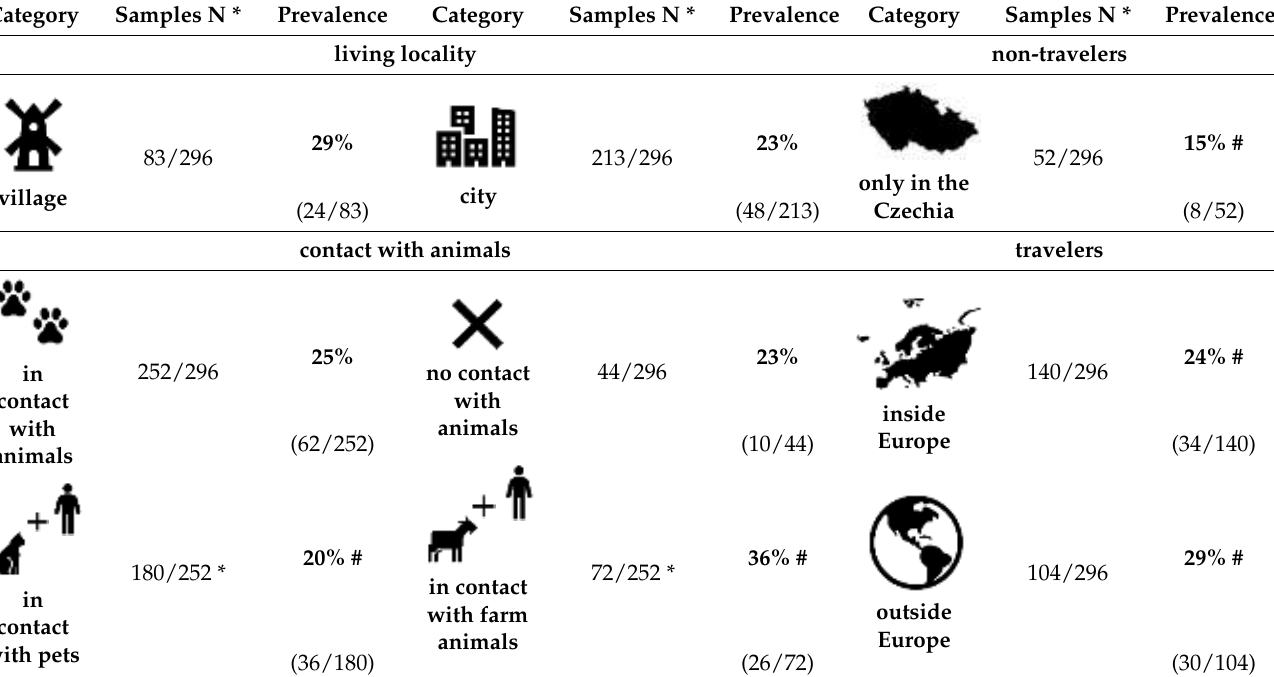
Table 4. Prevalence of Dientamoeba fragilis in human samples according to the specific categories such as lifestyle (village versus city life, traveling) and contact with animals (pets, farm animals). (Samples N — number of samples obtained in each category out of the total number of samples). * Total number of volunteers in contact with animals. # Statistically significant differences, for details see Sections 2.3.1 and 2.3.2.